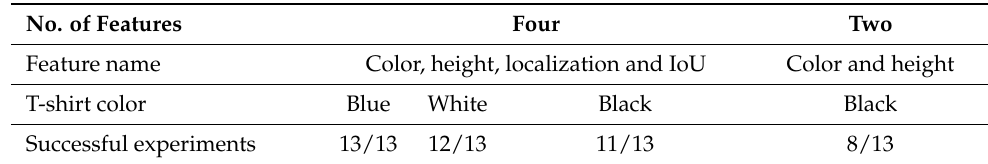
Table 1. Quantification of Experimental